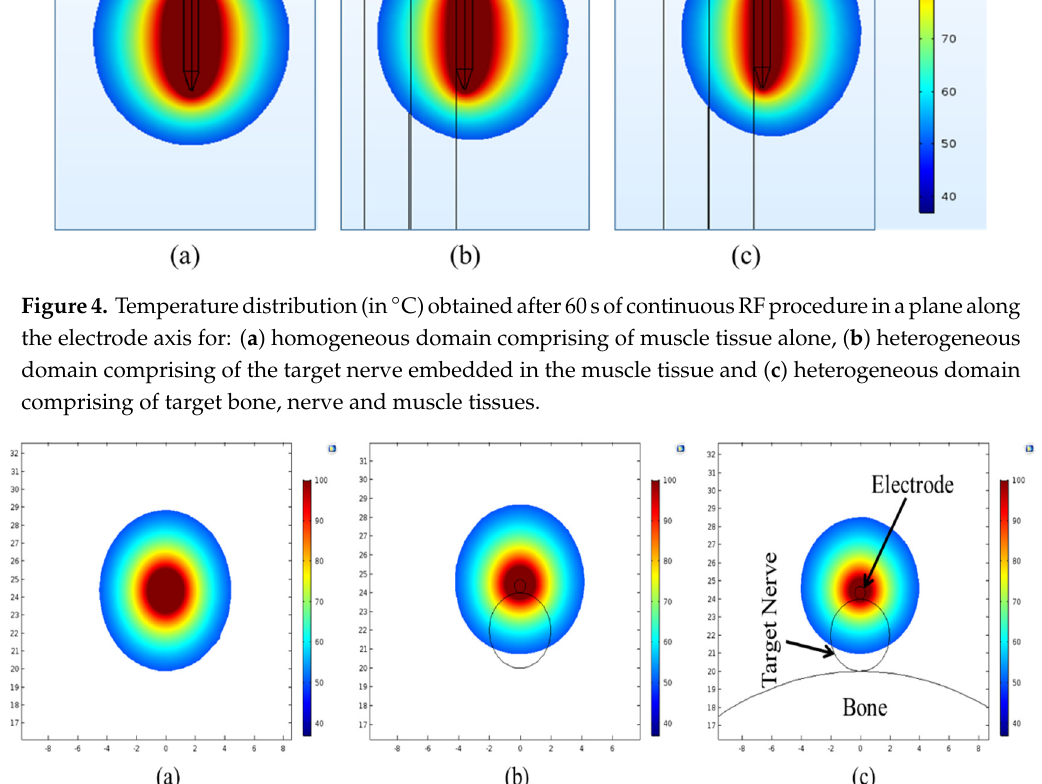
Figure 5. Temperature distribution (in °C) obtained after 60 s of continuous RF procedure in a plane normal to the electrode axis for: ( a ) homogeneous domain comprising of muscle tissue alone, ( b ) heterogeneous domain comprising of the target nerve embedded in the muscle tissue and ( c ) heterogeneous domain comprising of target bone, nerve and muscle tissues.